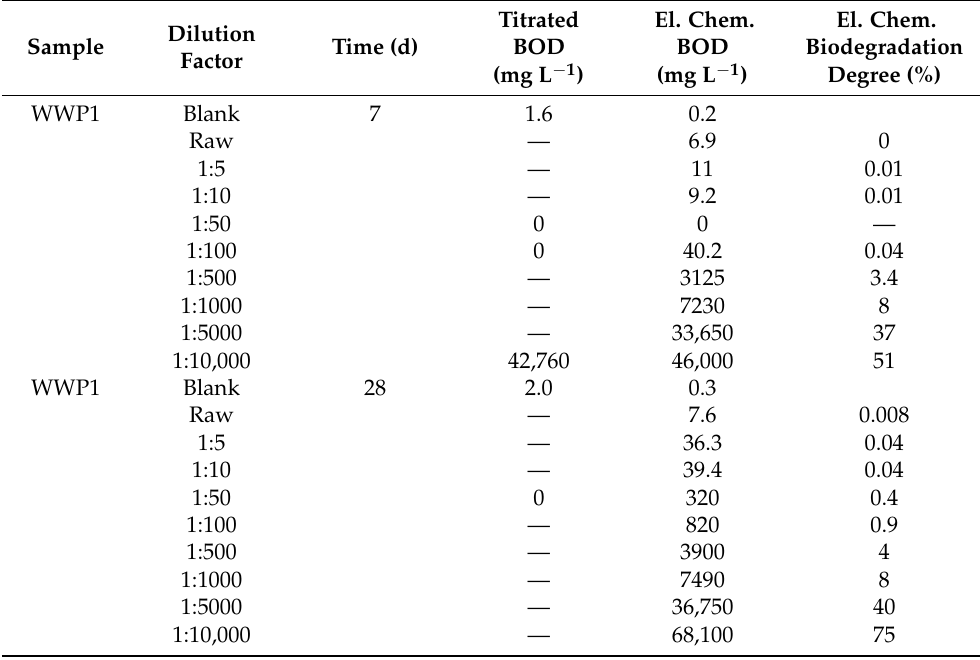
Table 2. The sample, dilution factor, and BOD values and the calculated degrees of biodegradation of the WWP1 sample measured with titration and electrochemical